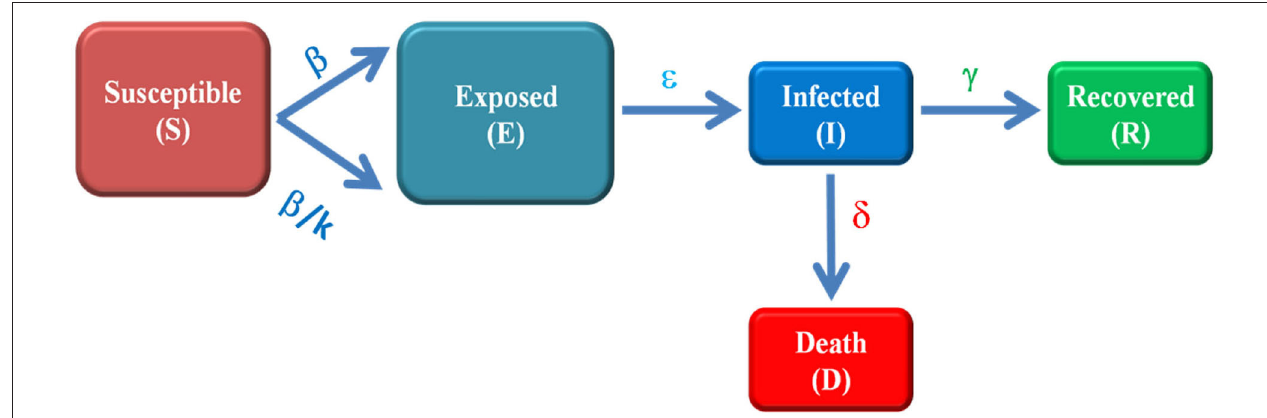
FIGURE 2 | Schematic of modified SEIRD model. Susceptible (S) is the number of un-infected persons, exposed (E) are the individuals which are infectious but not able to transmit the disease, infected (I) represent the active cases i.e., those who can transmit the disease, recovered (R) are the number of individuals who have been cured from disease and Death (D) represents the number of deaths from COVID-19. The parameters β , ε , γ and δ are transmission rate, incubation rate, recovery rate and death rate, respectively. The transmission rate ( β ) is optimized to β/ k , (0.2 ≤ k ≤ 1) to account for the impact of lockdown.